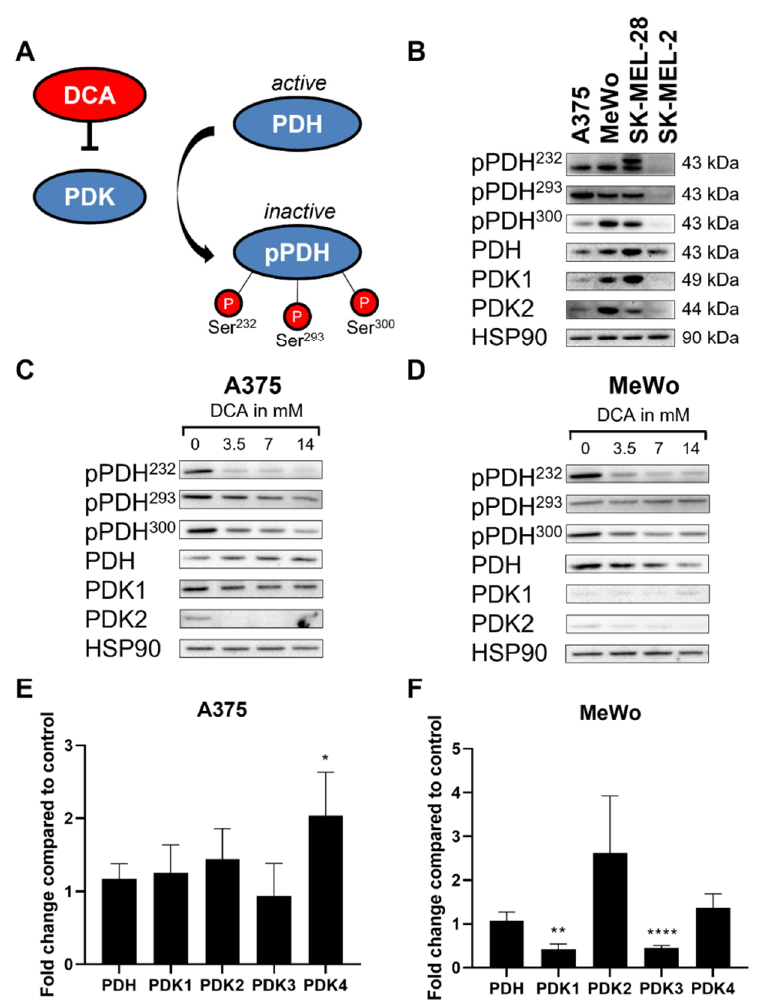
Figure 2. Effect of PDK inhibition on PDH and PDK levels in melanoma cells. ( A ) Schematic view of PDH/PDK axis. ( B ) Representative image of protein levels of metabolic enzymes at baseline with no treatment in all four cell lines. Representative image of protein levels after 24 h treatment with DCA in ( C ) A375 and ( D ) MeWo. Fold change in RNA levels of PDH and PDK1-4 after 24 h treatment with DCA compared to control in ( E ) A375 and ( F ) MeWo. ( E , F ) Data represent mean ± SD of 3 independent experiments, each performed in quadruplicate. Student’s t -test, * p < 0.05, ** p < 0.01, **** p < 0.0001, DCA-treated vs.